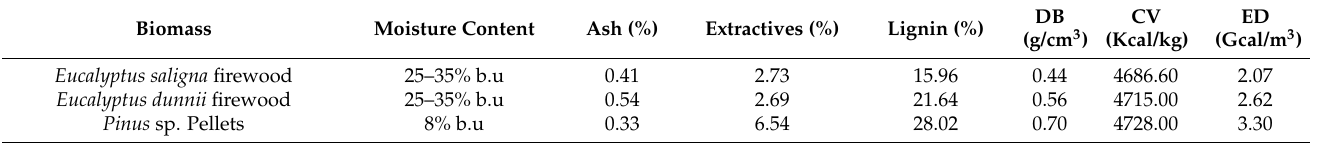
DB CV ED (g/cm 3 ) (Kcal/kg) (Gcal/m 3 )